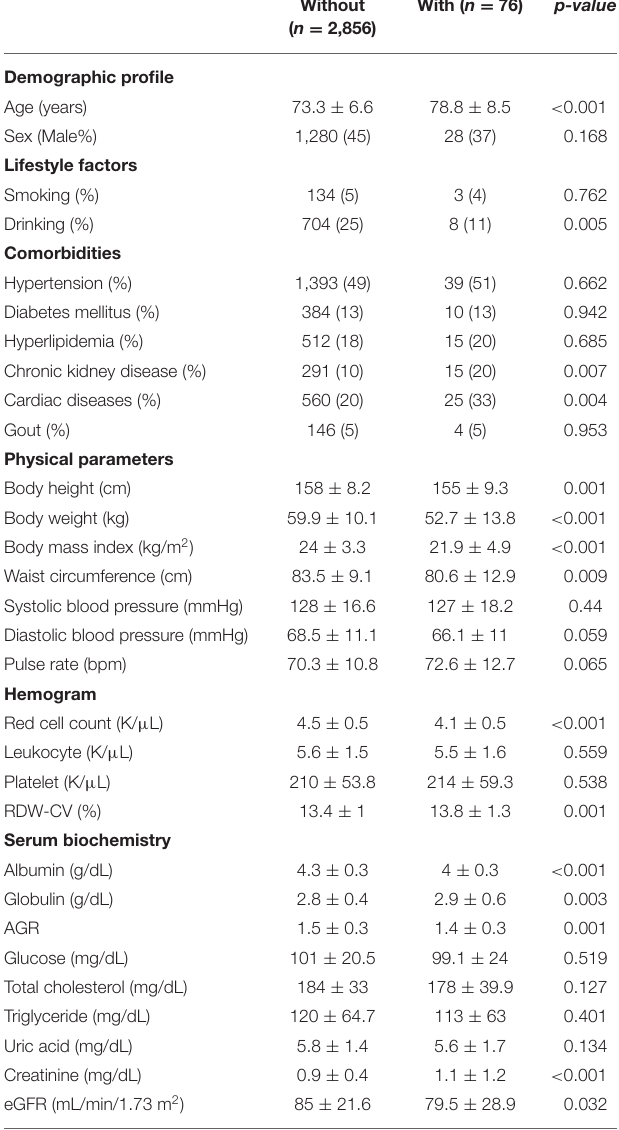
TABLE 2 | Clinical features based on the presence of frailty or not.